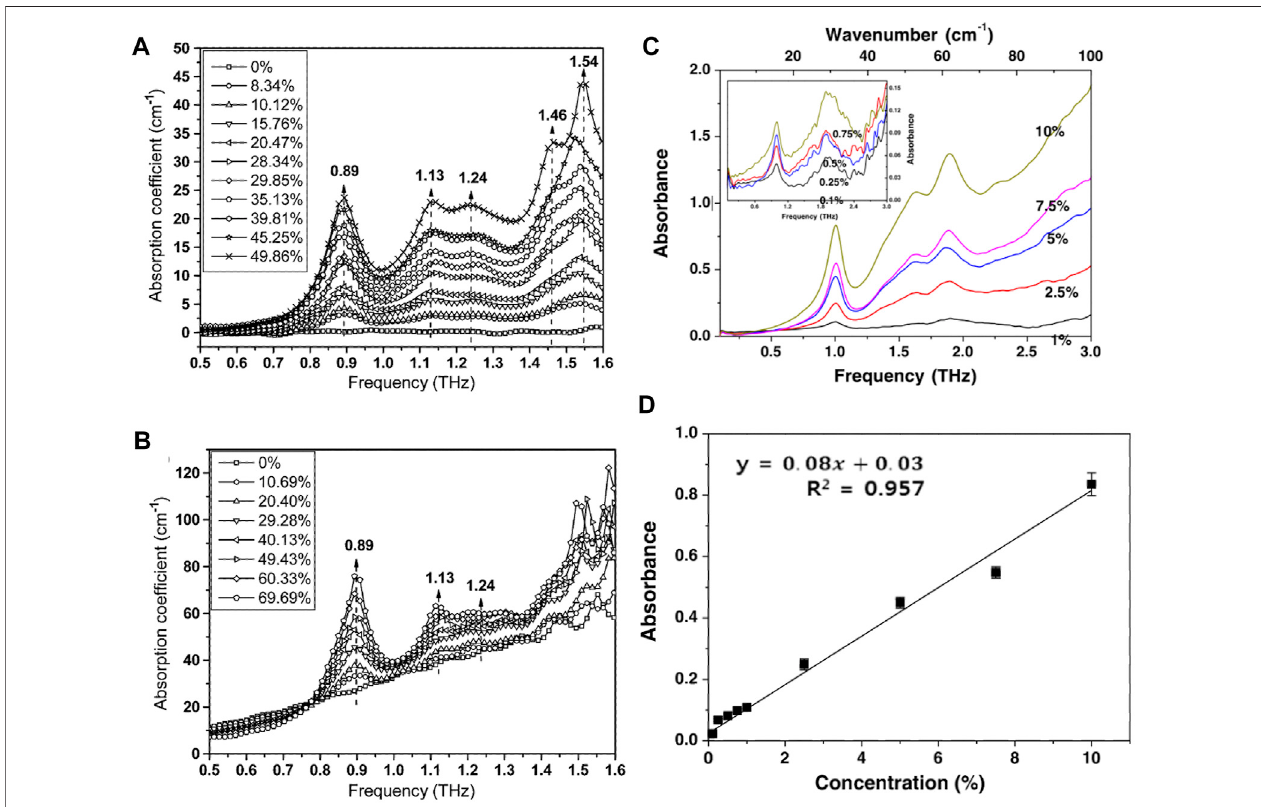
FIGURE 5 | THz absorption spectra of different weight ratios of imidacloprid (A) in polyethylene and (B) in glutinous rice fl our. The labels show the corresponding weightpercentagesofimidacloprid inthese mixtures. Thenumbers inthegraphrepresentthelocationofthepeaksand thearrows indicateanoverallincreasingtrendin the weight ratio of imidacloprid in the mixtures [20]. Reproduced with permission. © 2010 IEEE. (C) Absorption spectra of methomyl at 0.1 – 3 THz and (D) calibration curve at 1 THz [83]. Reproduced with permission. © 2015 Springer Science Business Media New